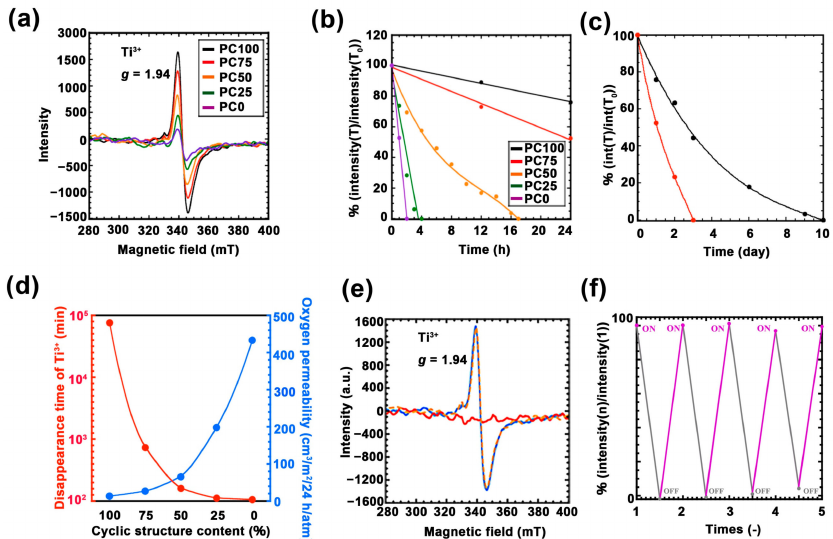
Figure 5. ( a ) Electron spin resonance (ESR) spectra for each UV irradiated the polycarbon- ate/titania hybrid films after 1 h: PC100 (black line), PC75 (red line), PC50 (orange line), PC25 (green line), and PC0 (purple line). ( b ) Time variation of normalized ESR intensity of each UV irradiated hybrid film with hour scale: PC100 (black line), PC75 (red line), PC50 (orange line), PC25 (green line), and PC0 (purple line). ( c ) Time variation of normal- ized ESR intensity of each UV irradiated hybrid film with day scale: PC100 (black line) and PC75 (red line). ( d ) Correlation diagram of each hybrid film of lifetime of Ti 3+ (red line) and oxygen permeability (blue line). ( e ) ESR spectra for PC100 after each treatment: UV irradiation after 2 h (blue line), UV irradiation after 12 h (orange dotted line), and UV irradiation after 2 h and heating treatment (red line). ( f ) Repeated UV irradiation test of PC100: after 80 ◦ C incubation for 2 h (black plot), and after UV irradiation for 2 h (purple